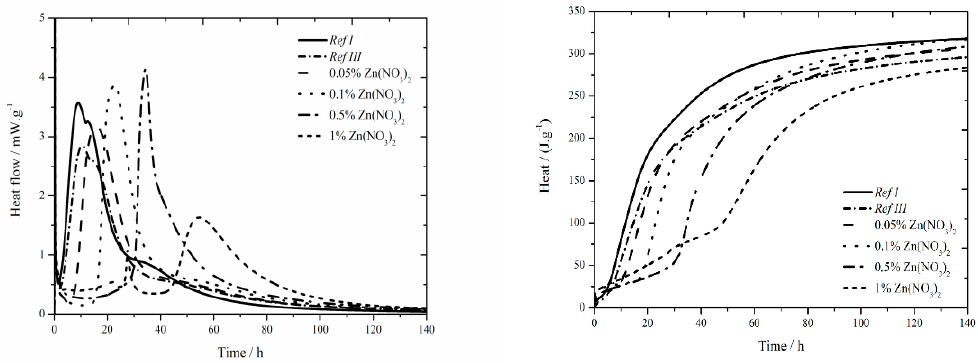
Figure 2. Isothermal curves for Zn(NO 3 ) 2 samples.